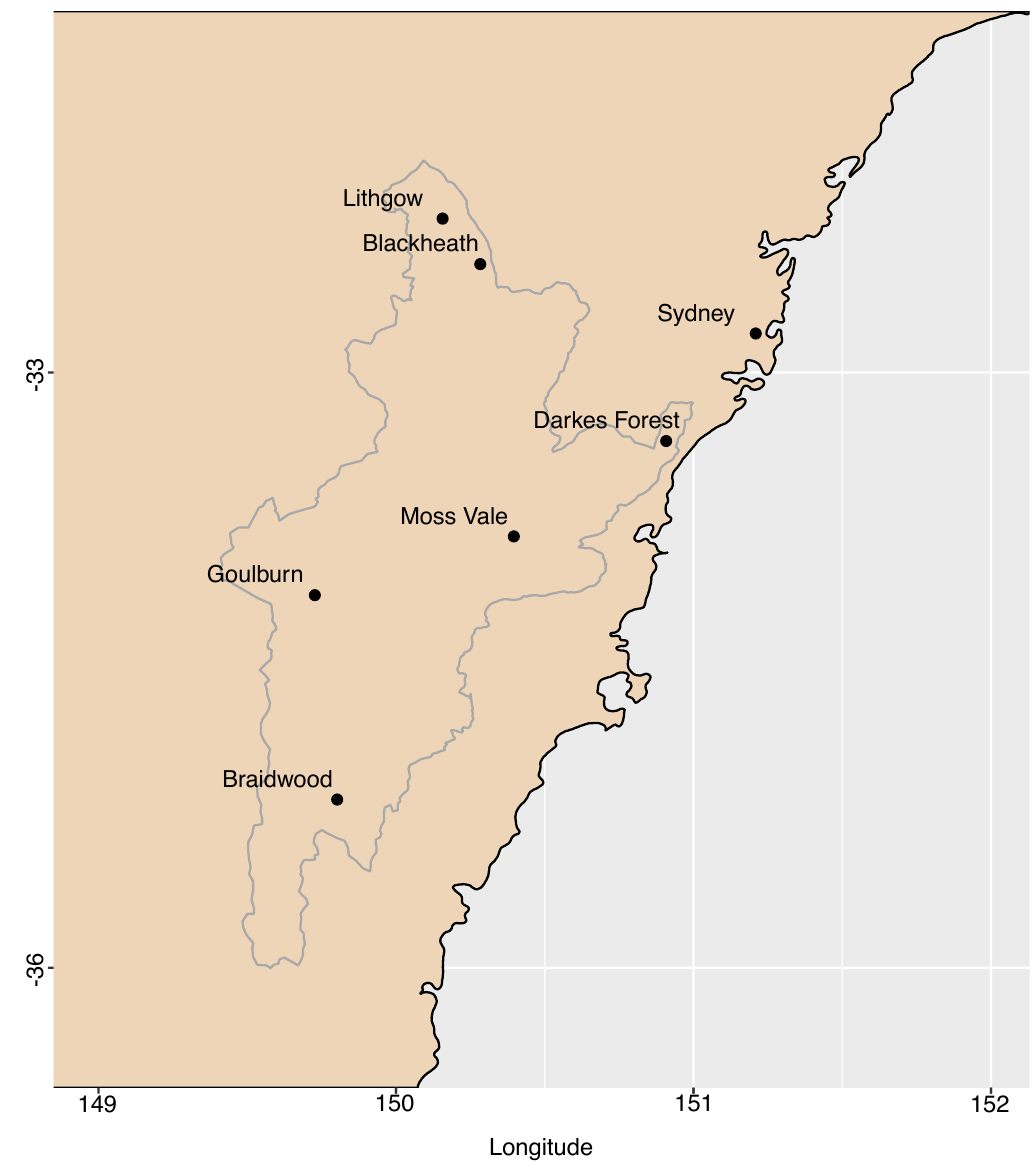
Figure 1. Location map of the Sydney catchment area (outline in dark grey): the six sites where data were obtained and the Sydney central business district (black